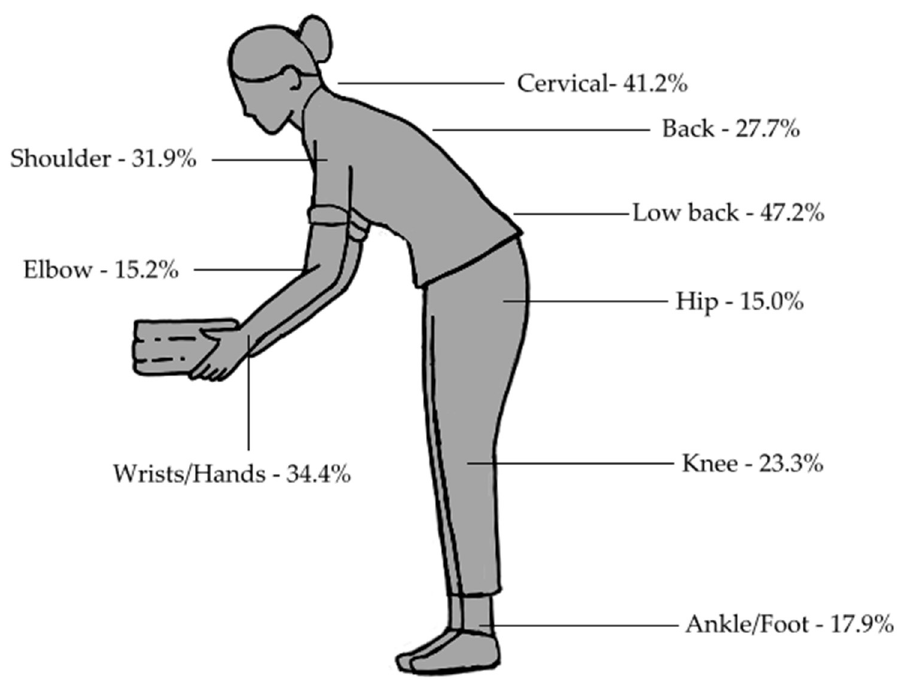
Figure 2. Pain by body region in the previous 7 days.